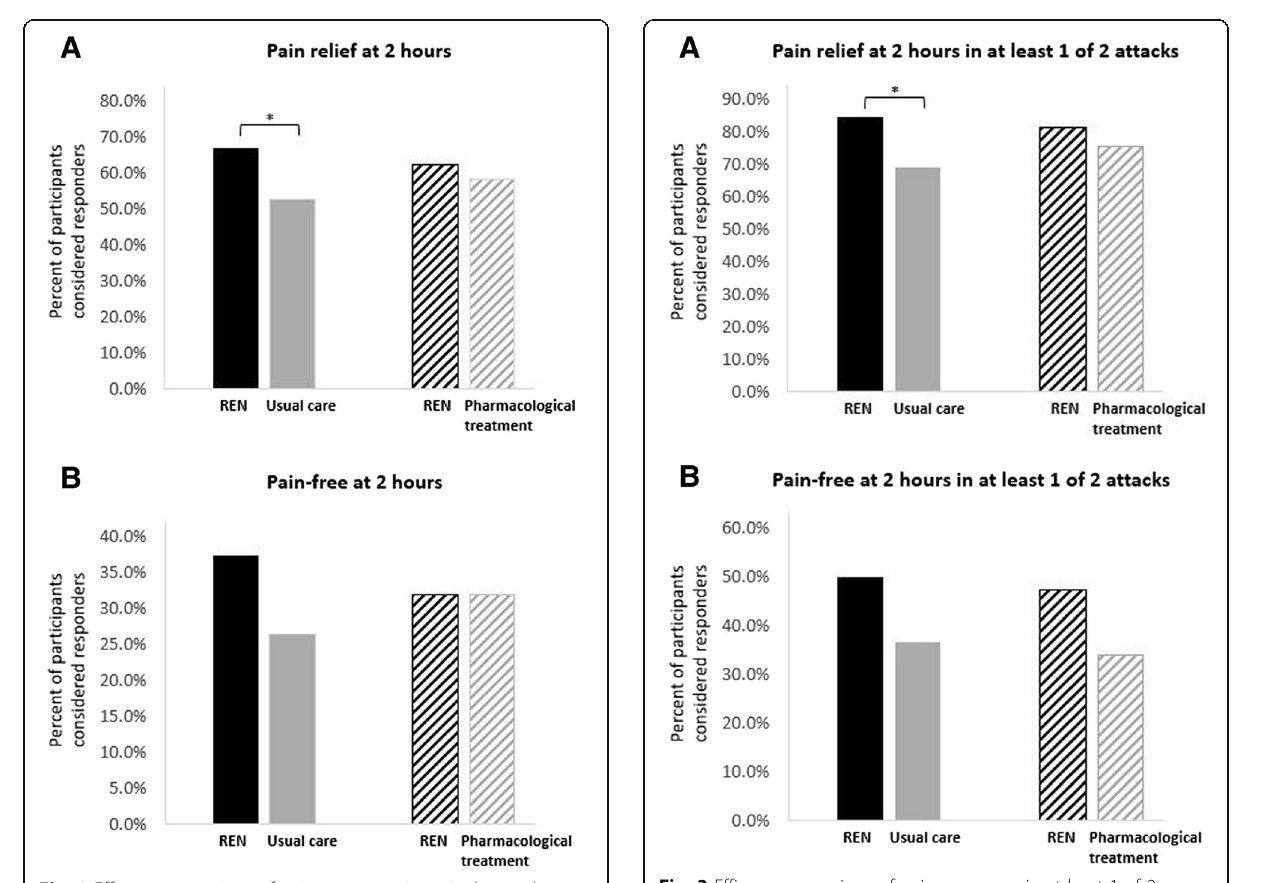
Fig. 2 Efficacy comparison of pain responses in a single attack. a Pain relief at 2 h post-treatment of REN (solid black and diagonal black) compared with usual care (solid gray) and pharmacological treatment (diagonal gray). b Pain-free at 2 h post-treatment of REN (solid black and diagonal black) compared with usual care (solid gray) and pharmacological treatment (diagonal gray). * p < 0.05